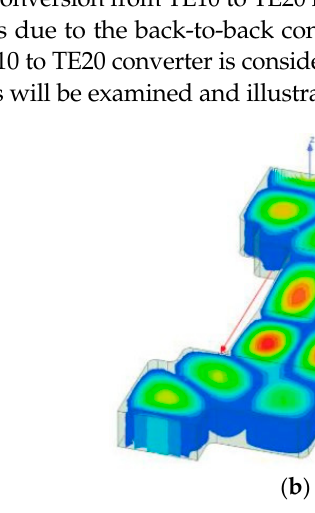
Figure 5. Electrical field in the back-to-back mode converter at two frequencies; ( a ) at 14.89 GHz and ( b ) at 15 GHz.